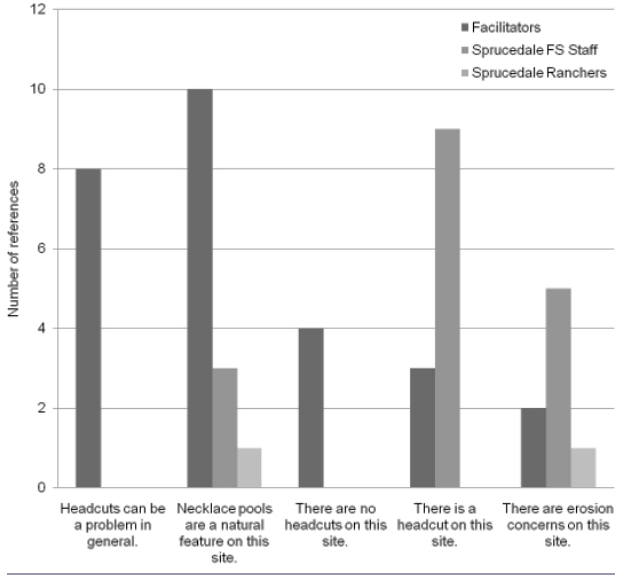
Fig. 1 . Frequency of references to erosion categorized by usage and stakeholder group. Groups that did not mention erosion are not